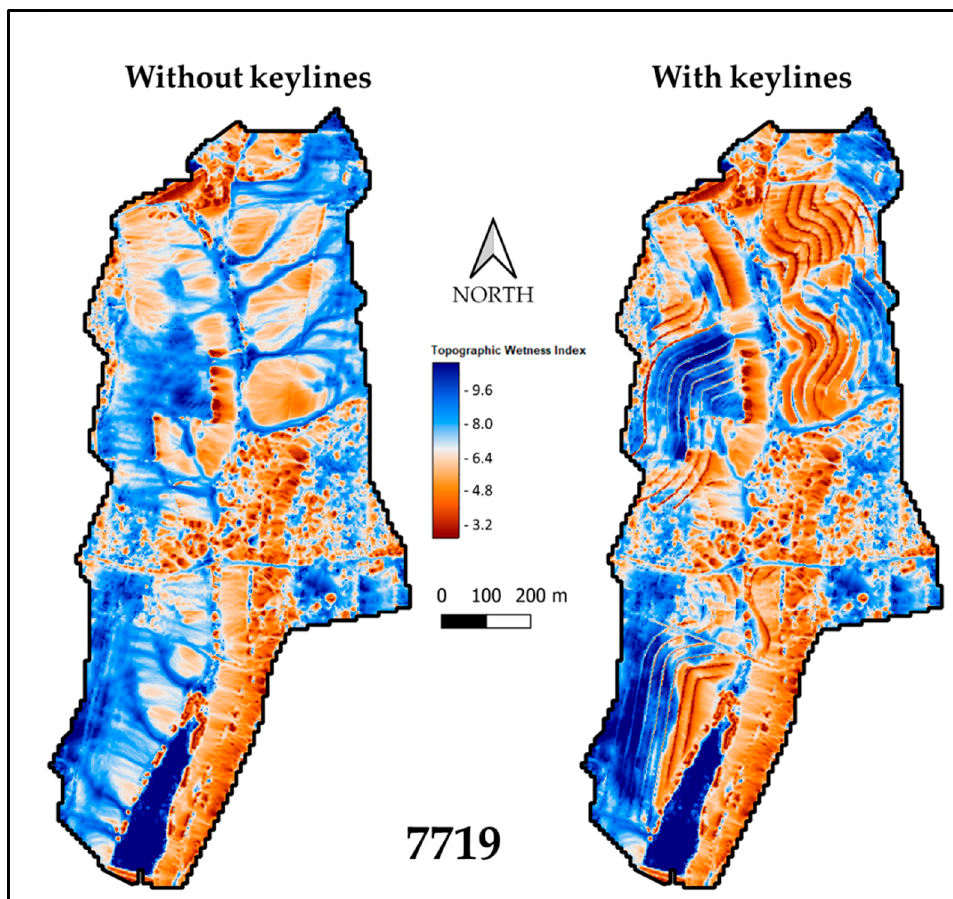
Figure 5. Topographic Wetness Index (TWI) maps with and without the keylines for basin 7719.